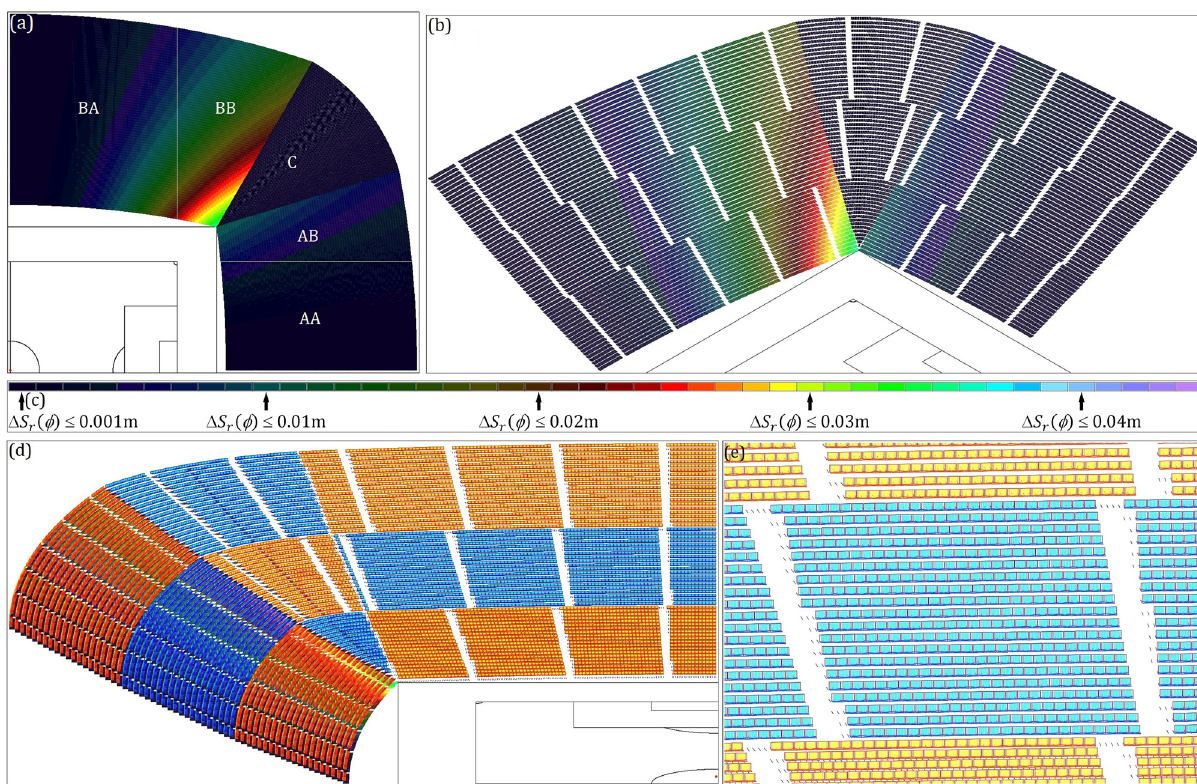
Figure 7: The stadium stands ( for x Δ 3 m = , y Δ 7 m = , n m k , , 20 = ) : ( a ) depth of the rows ( top view ) , ( b ) depth of the rows ( SW Isometric view ) , ( c ) color palette, ( d ) the arrangement of seats in the stands, and ( e ) a view of a sector in the stand behind the